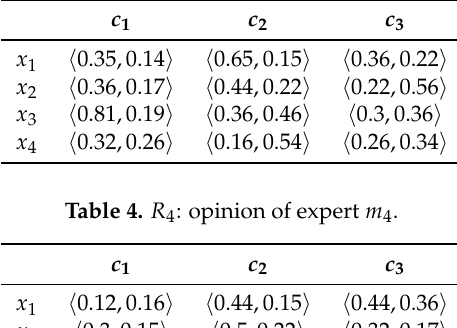
Table 3. R 3 : opinion of expert m 3 .